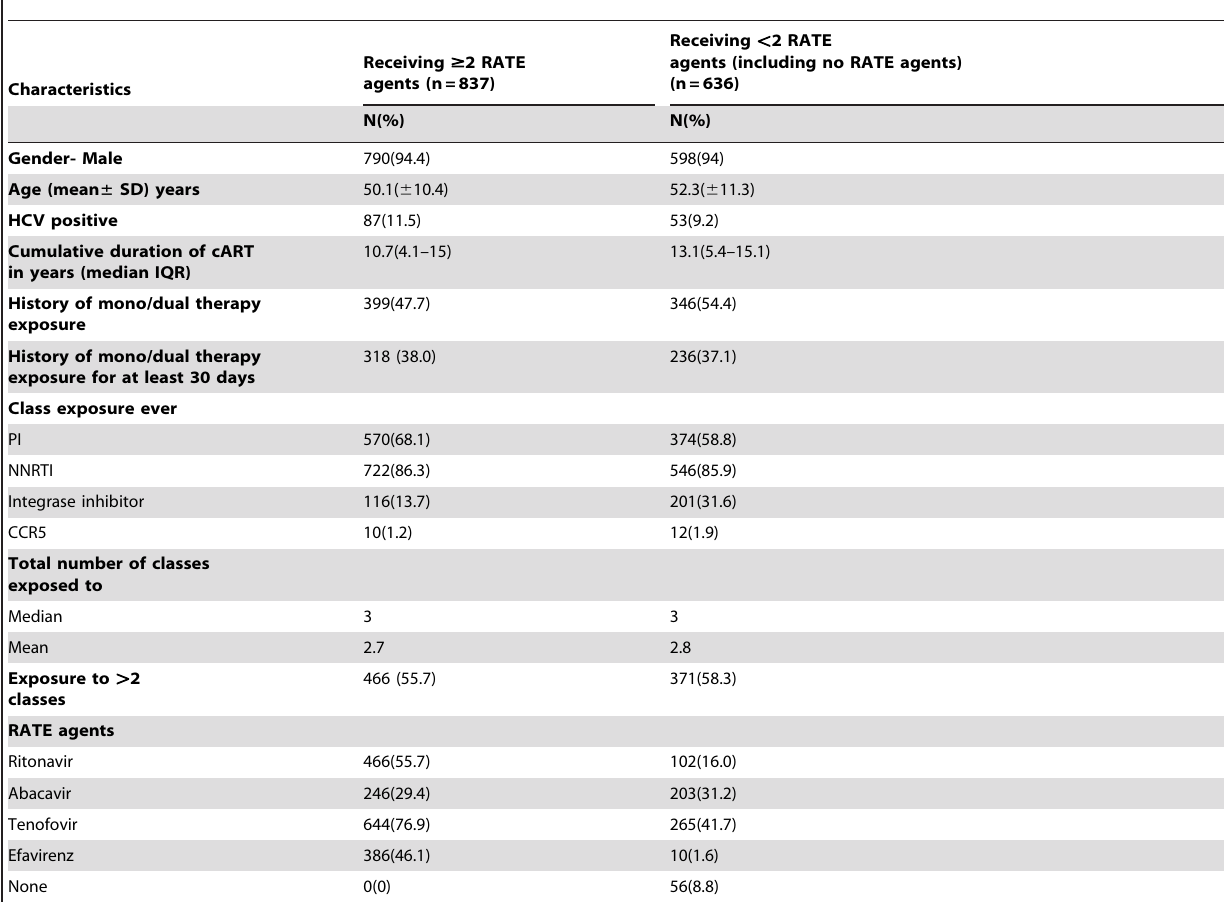
Table 3. Characteristics of those receiving $ 2 RATE agents and , 2 RATE agents in AHOD.